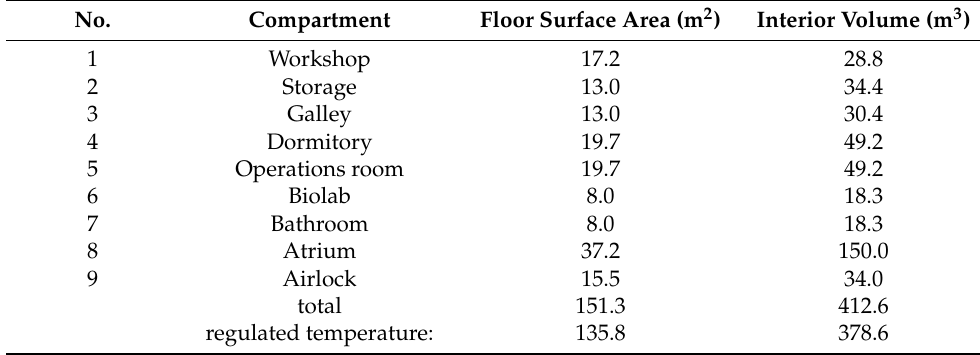
Table 3. Compartments in LUNARES